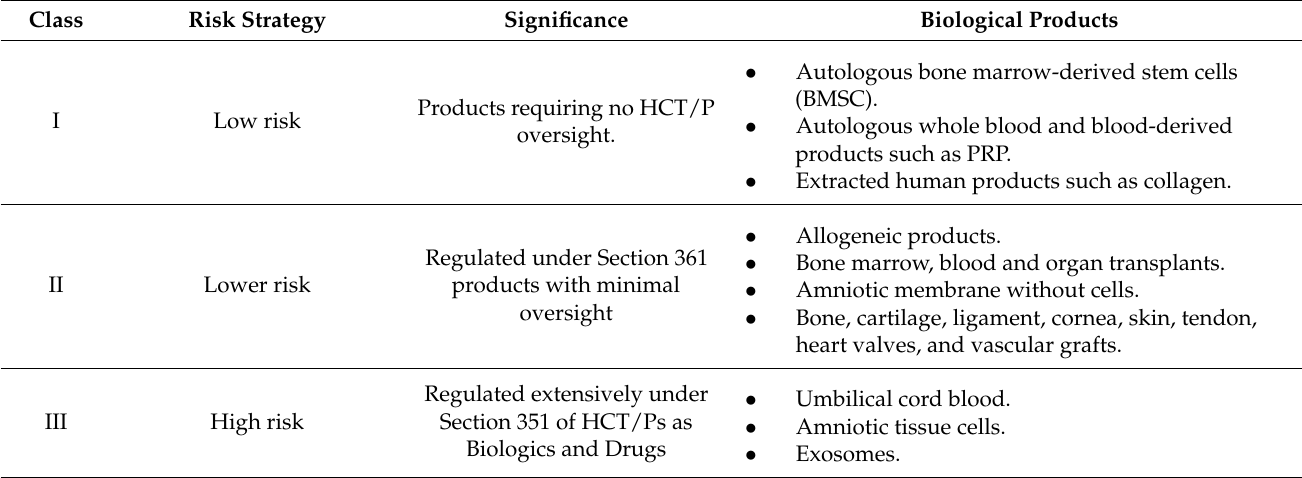
Table 1. Classification of biological products.